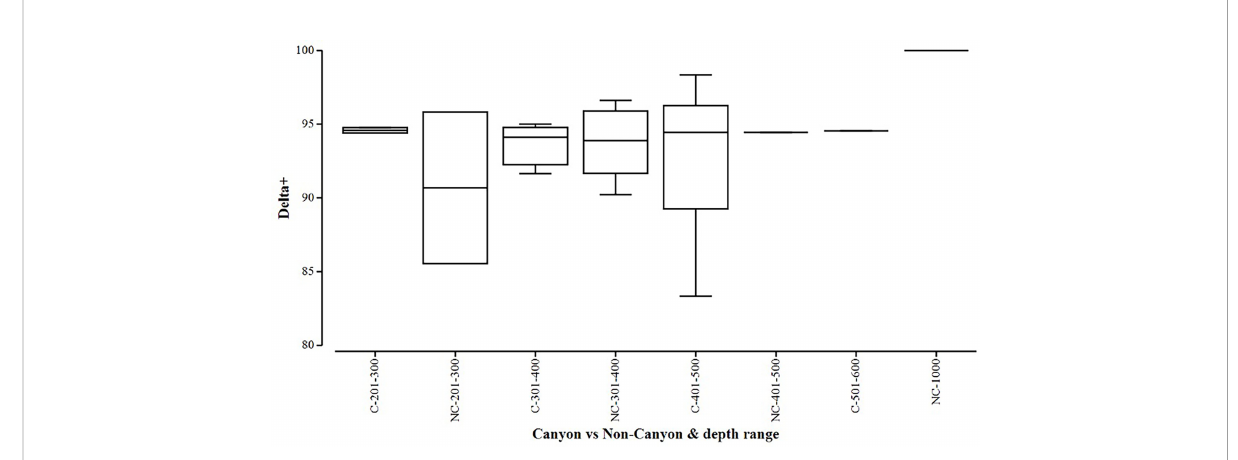
FIGURE 5 Box plot showing average taxonomic distinctiveness (denoted by delta+) represented within each canyon (C) vs. non-canyon (NC) depth class within the range of 201-1000